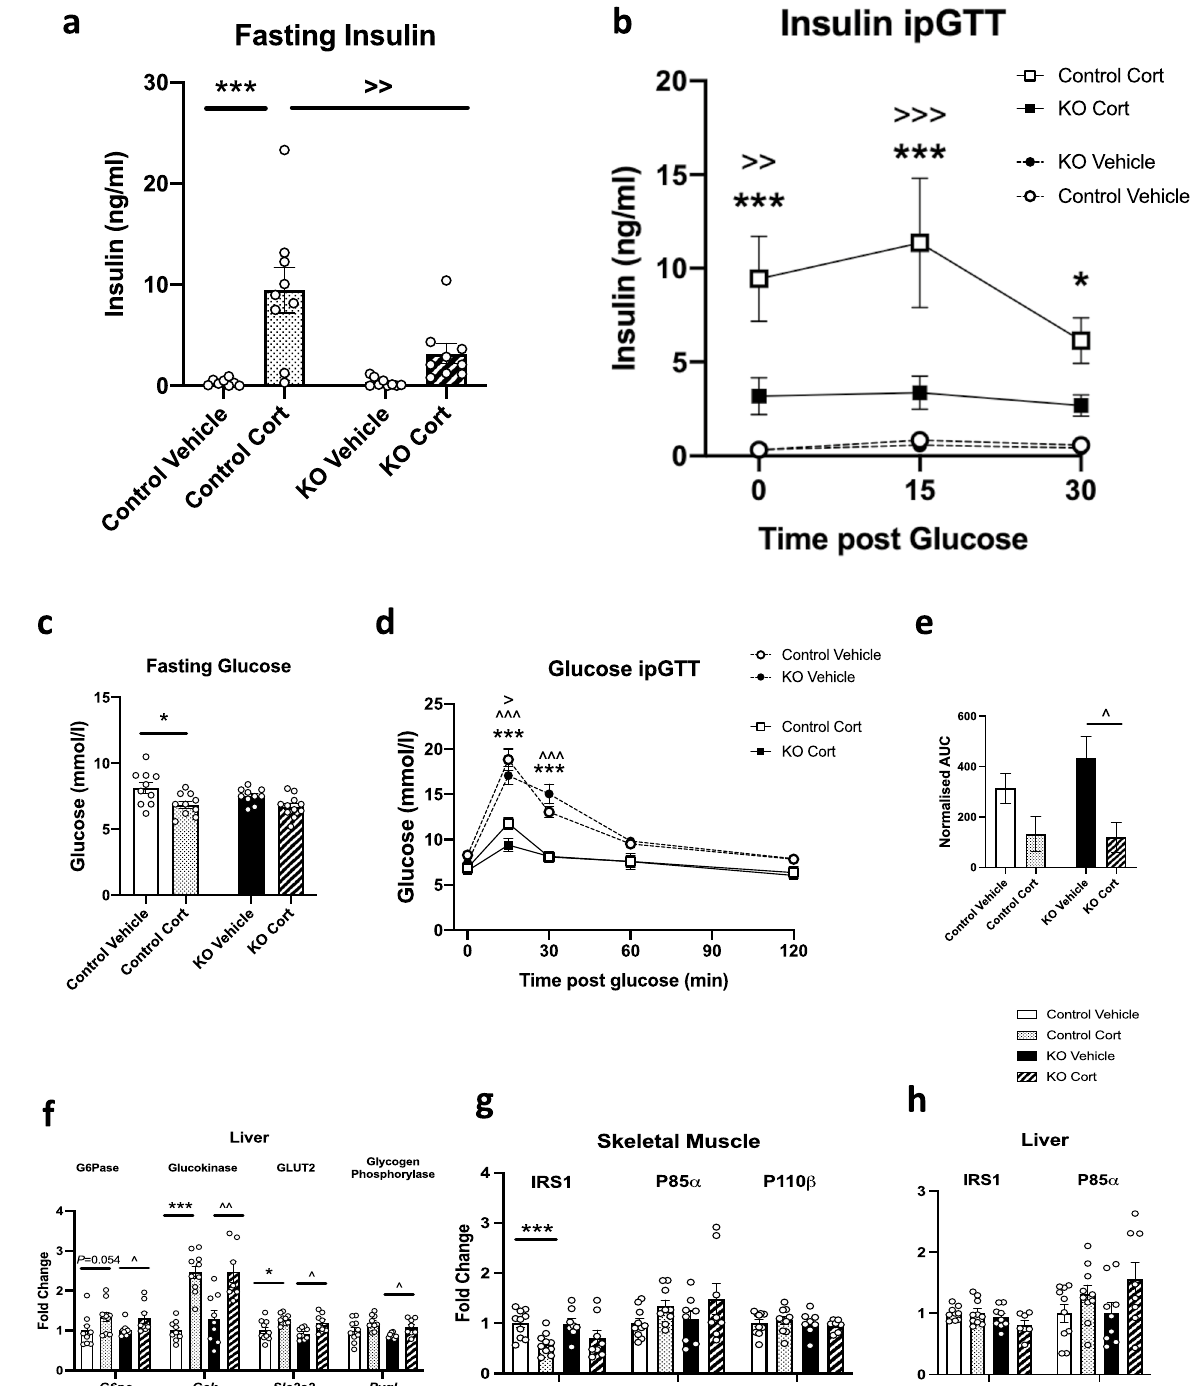
Figure 4. Female AgRP-GR KO mice are partially protected from corticosterone (Cort)-induced insulin resistance. ( a ) Fasting insulin following a 5 h day time fast in control and AgRP-GR KO mice treated with Cort for 10 days. ( b ) Insulin concentrations during an intraperitoneal glucose tolerance test (ipGTT) following 10 days Cort treatment. ( c ) Fasting glucose, ( d ) glucose levels during an intraperitoneal glucose tolerance test (ipGTT), ( e ) area under the curve of the glucose ipGTT undertaken following 10 days Cort treatment, ( f ) mRNA expression of genes associated with gluconeogenesis in liver after 3 weeks Cort treatment. mRNA expression of genes associated with insulin resistance in ( g ) skeletal muscle and ( h ) liver. ( f – h ) Samples were taken from non-fasting animals ( a ) n = 8–10, ( b ) n = 8–9, ( c – e ) 8–10 Two-way ANOVA with Tukey Multiple Comparison test, ( f – h ) n = 7–10, Mann–Whitney non-parametric t-tests. * P < 0.01, *** P < 0.001 control vehicle versus Cort, ^ P < 0.05, ^^ P < 0.01 KO, ^^^ P < 0.001 vehicle versus Cort, > P < 0.05, >> P > 0.01, >>> P > 0.001 control Cort versus KO